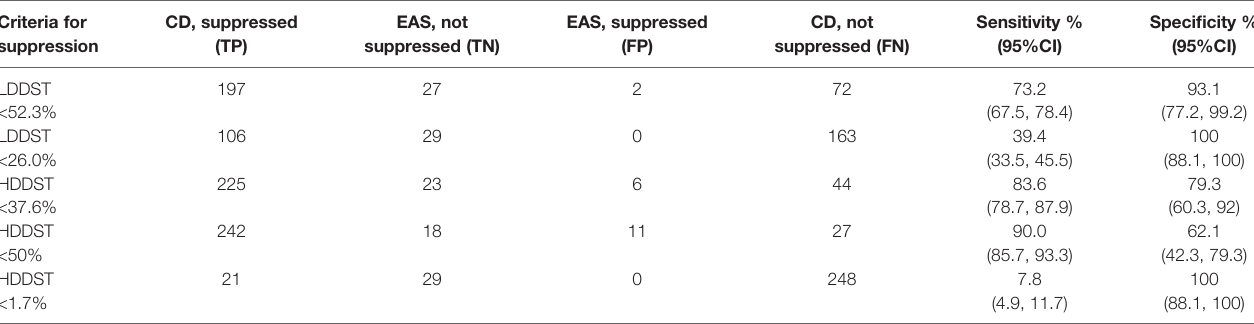
TABLE 2 | Utility of low- and high-dose dexamethasone suppression test for the differential diagnosis of CD and EAS. Criteria for